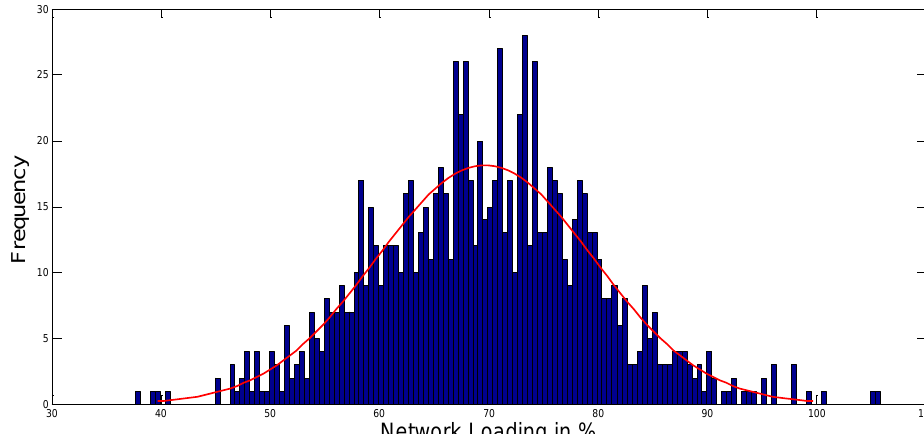
Figure 3. Demand scenarios using Monte-Carlo simulation.